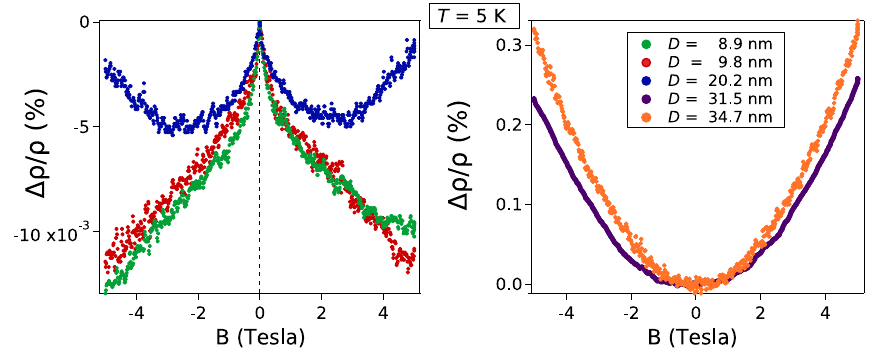
Figure 3. Transverse magnetoresistance of the samples measured at 5 K.